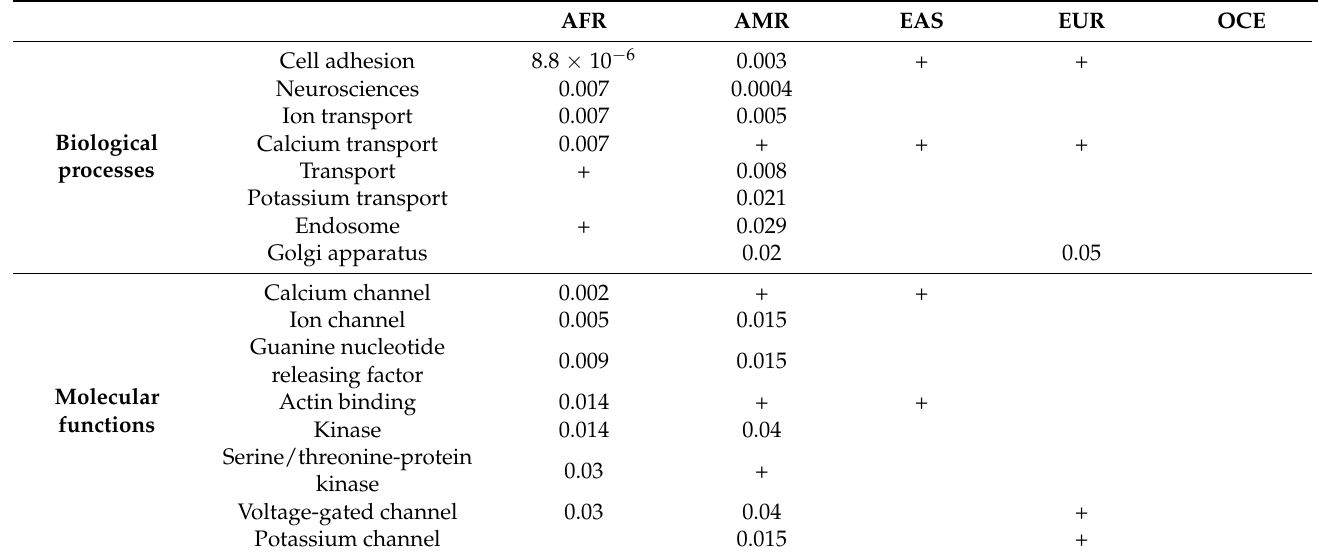
Table 4. Functional annotation of genes for ARSA SNPs obtained by the DAVID bioinformatics